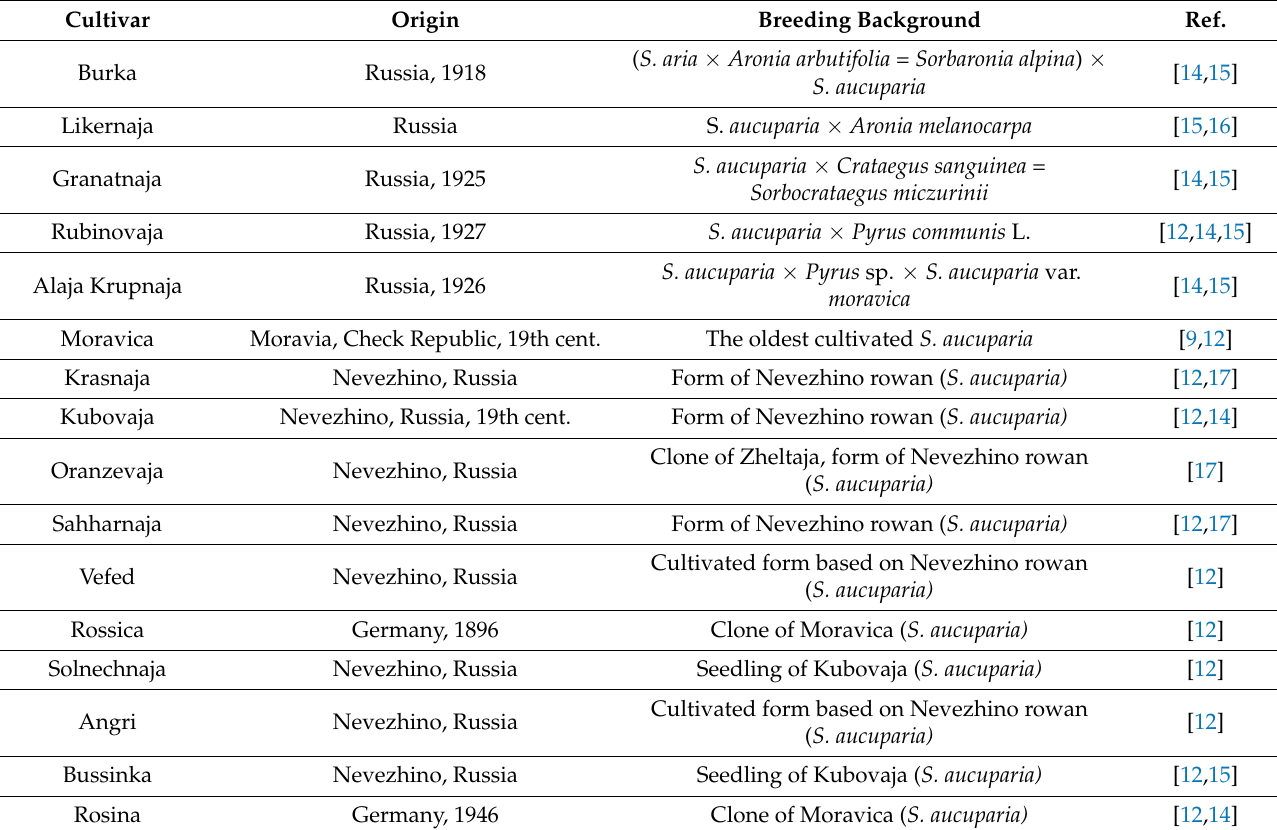
Table 1. Description of selected sweet rowanberry S. aucuparia